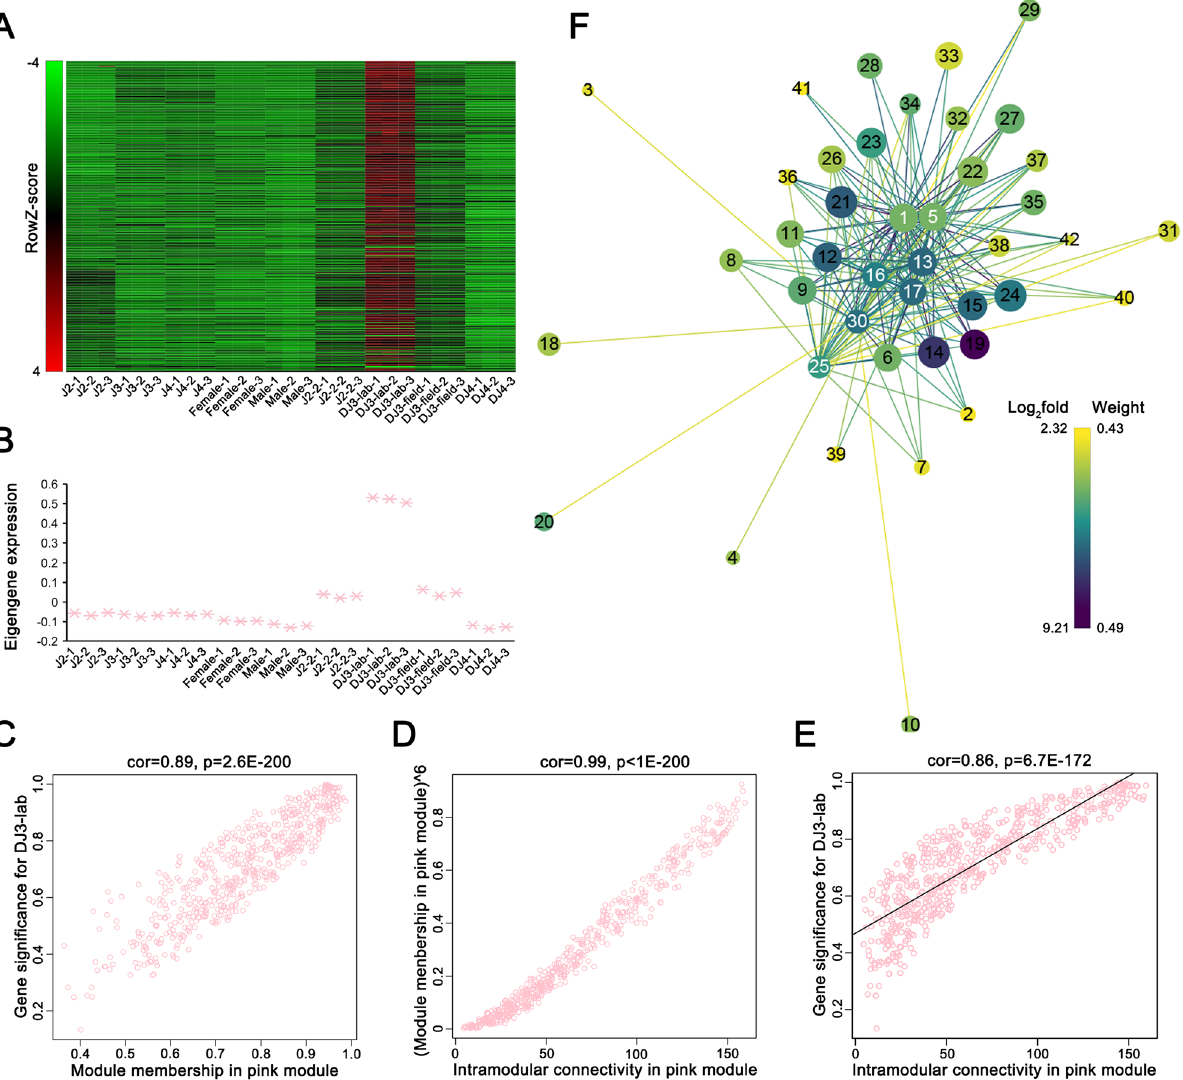
Figure 3. Weighted gene coexpression analysis (WGCNA) revealed a gene-network module enriched in Bursaphlenchus xylophilus DJ3-lab. ( A ) Heatmap of the pink module genes (rows) across the samples (columns). ( B ) The pink module eigengene expression values (y-axis) across the samples (x-axis) ( C ) GS for DJ3-lab vs. MM in the pink module. ( D ) MM raised to power 6 (y-axis) vs. IC (x-axis) for the pink module. ( E ) GS (y-axis) vs. IC (x-axis) for the pink module. ( F ) Gene network for the 7 selected genes in the pink module with the top 30 highest GS to DJ3-lab (detailed in Table S4 and Table S5). Prefuse Force Directed Layout was applied based on the weight value between two genes. The size of the dots represents GS (from 0.9361 to 0.9984). The color of the dots represents log 2 fold (from 2.3238 to 9.2053) for the FPKM of DJ3-lab vs. the average FPKM of the other samples. The colors of the lines represent the weight value between two genes (from 0.4330 to 0.4921). The label of dots is listed based on IC (from 97.0445 to 159.5326), and the 7 selected dots are highlighted with white color